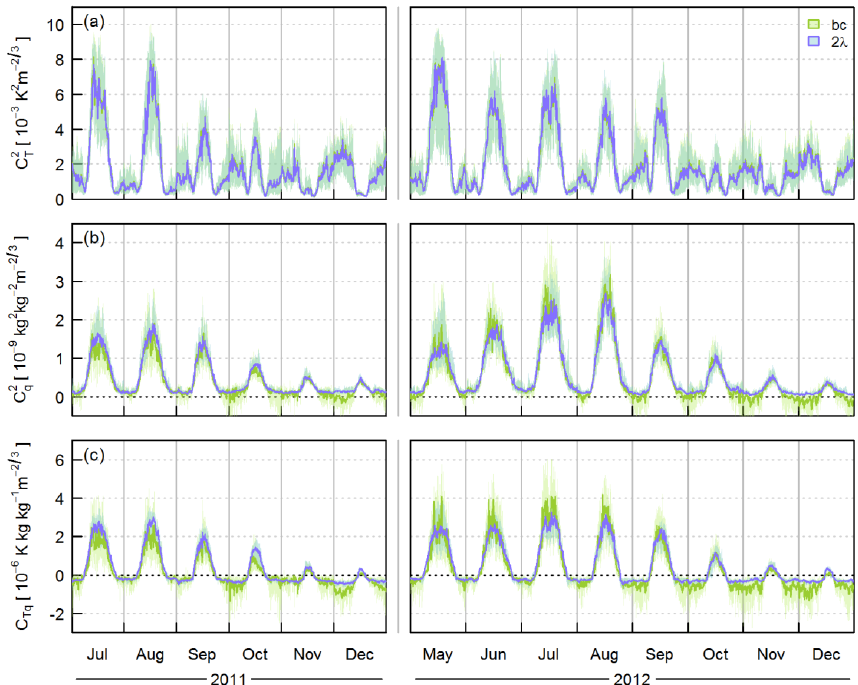
Figure 7. Median diurnal cycles and inter-quartile ranges (shading) of the meteorological structure parameters (a) C 2 calculated using the bichromatic (bc) and two-wavelength (2 λ ) techniques. In (c) C Tq for the two-wavelength technique is given by ± 0.8( C 2 C 2 q ) 1 / 2 T